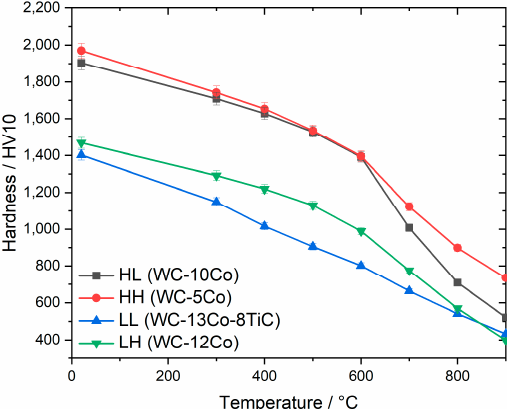
Figure 4. Hardness of the studied cemented carbides as a function of temperature.